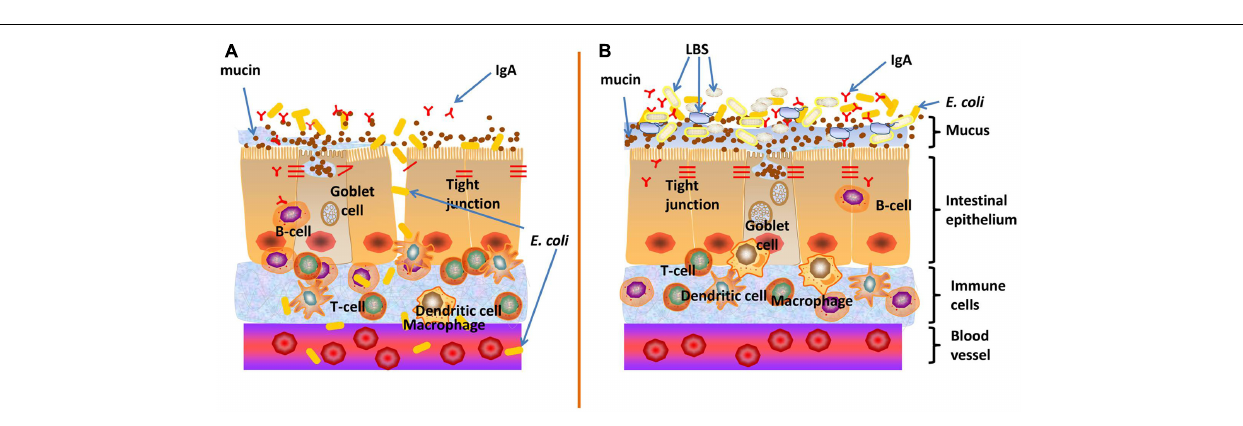
FIGURE 8 | Proposed mechanisms on how LBS exert preventive effect against neonatal E. coli K1 translocation. (A) The intestinal barrier function of neonates is not fully developed, which may provide opportunities for E. coli K1 translocation across the gut barrier into the blood stream, leading to bacteremia and meningitis. (B) LBS promote the formation of neonatal intestinal barrier function, including enhancement of mucin and IgA productions and up-regulation of the expression of ZO-1 to seal the intercellular space of intestinal epithelial cells (reflected by a decrease in the intestinal permeability). This multifactorial approach enhances intestinal barrier functions and thereby limits bacterial translocation across the neonatal intestinal